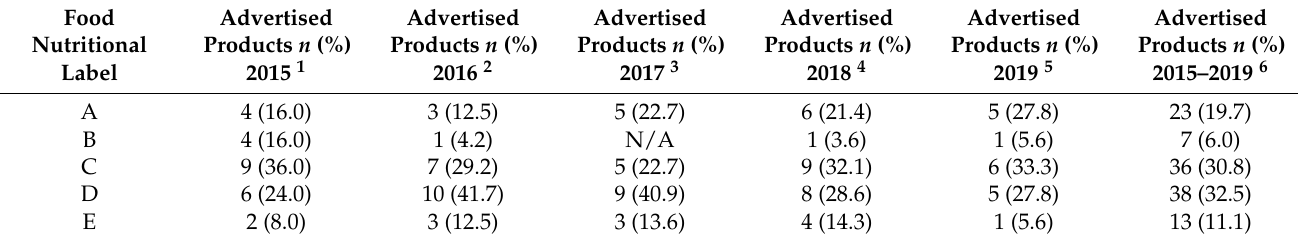
Table 2. Nutri-score classification of the advertised breakfast products by year.